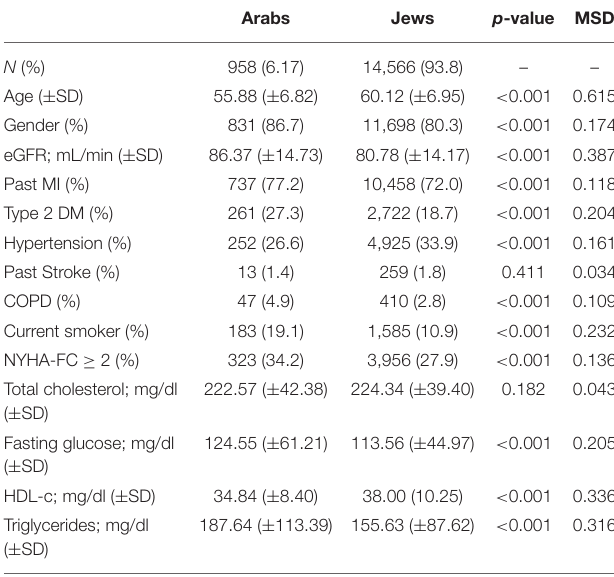
TABLE 1 | Baseline characteristics of the study population by